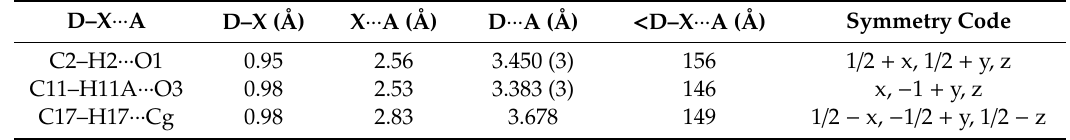
Figure 2. The asymmetric unit of compound 4a with 50% probability thermal ellipsoids. Table 3. Intermolecular interactions of compounds 4a.